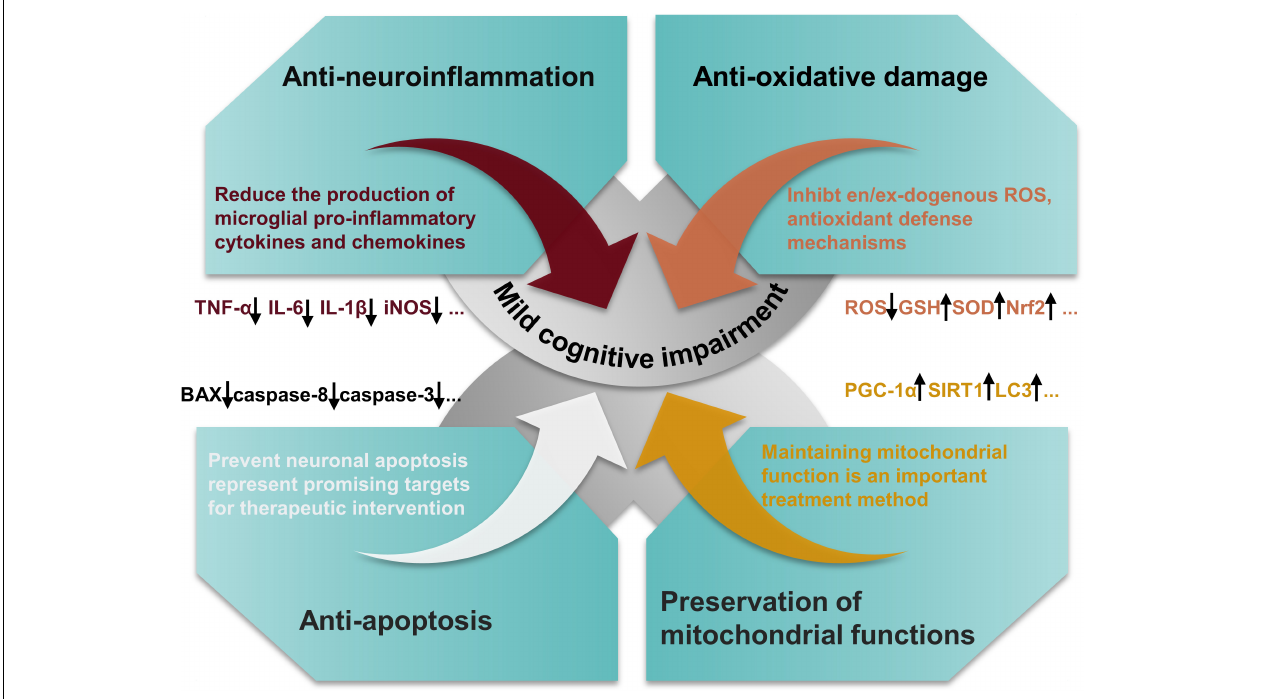
FIGURE 3 | Salient pharmacological features of ellagic acid (EA) elicited by involving anti-oxidant effects, modulation of synthesis of anti-inflammatory molecules, inhibition of neuronal apoptosis, and preservation of mitochondrial